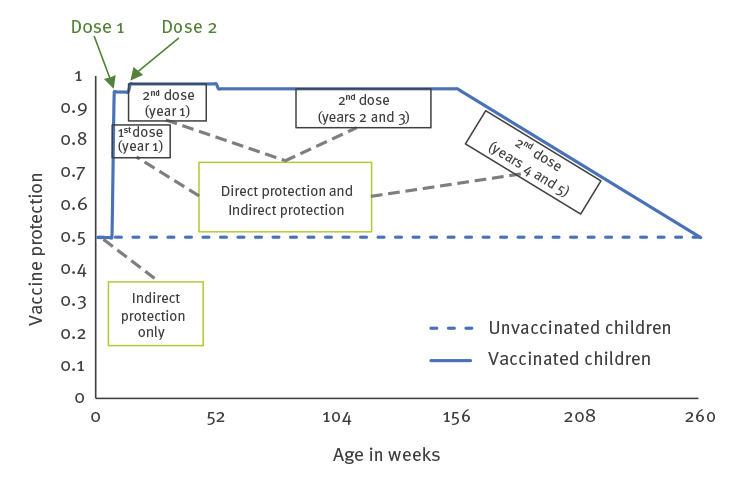
Illustration of rotavirus vaccine protection against gastroenteritis in children